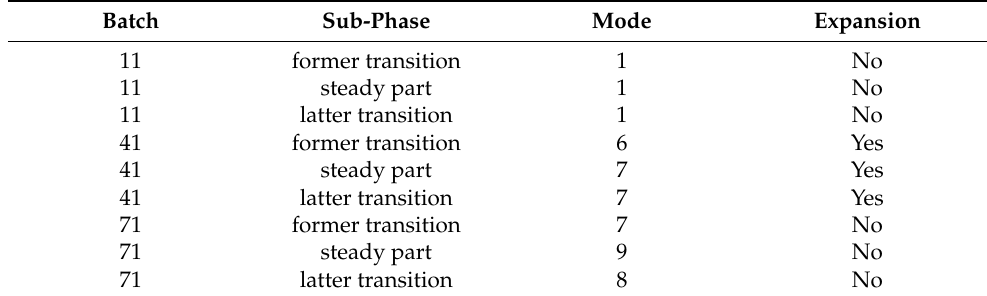
Table 2. Specific arrangements for online monitoring of experimental